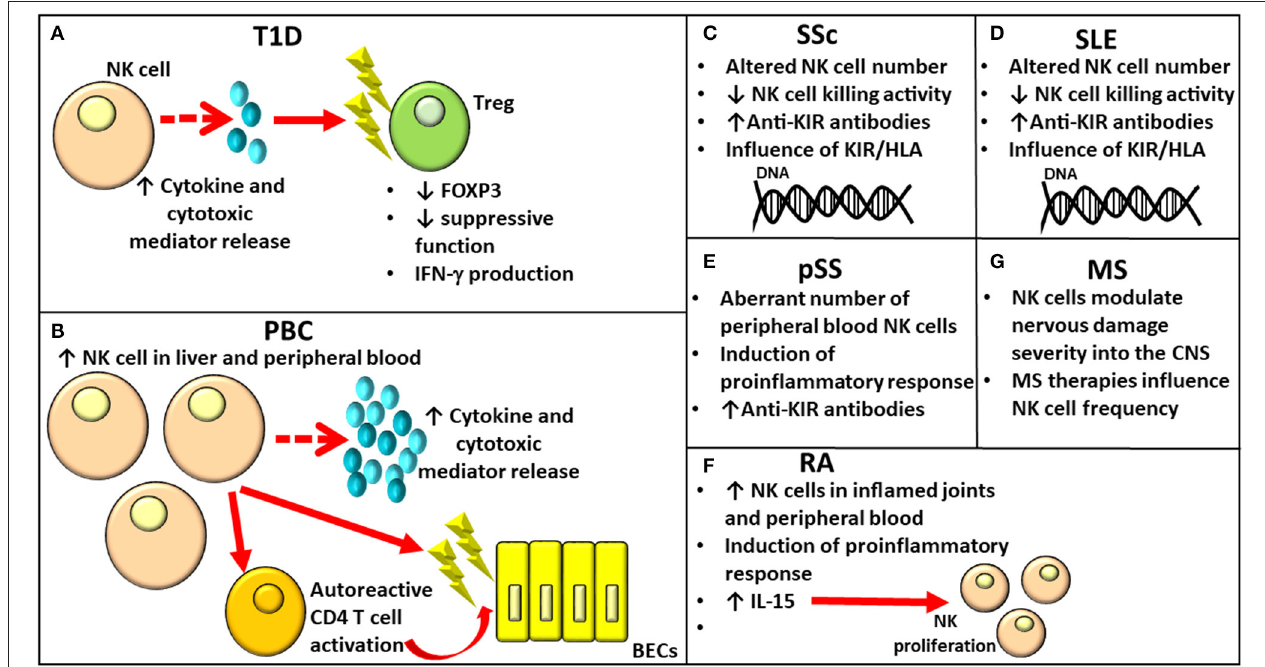
FIGURE 2 | Role of NK cells in various autoimmune diseases. NK, Natural